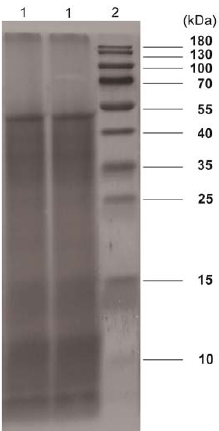
Figure 4. SDS-PAGE analysis of PSAF. Land 1: PSAF; Land 2: standard protein marker.